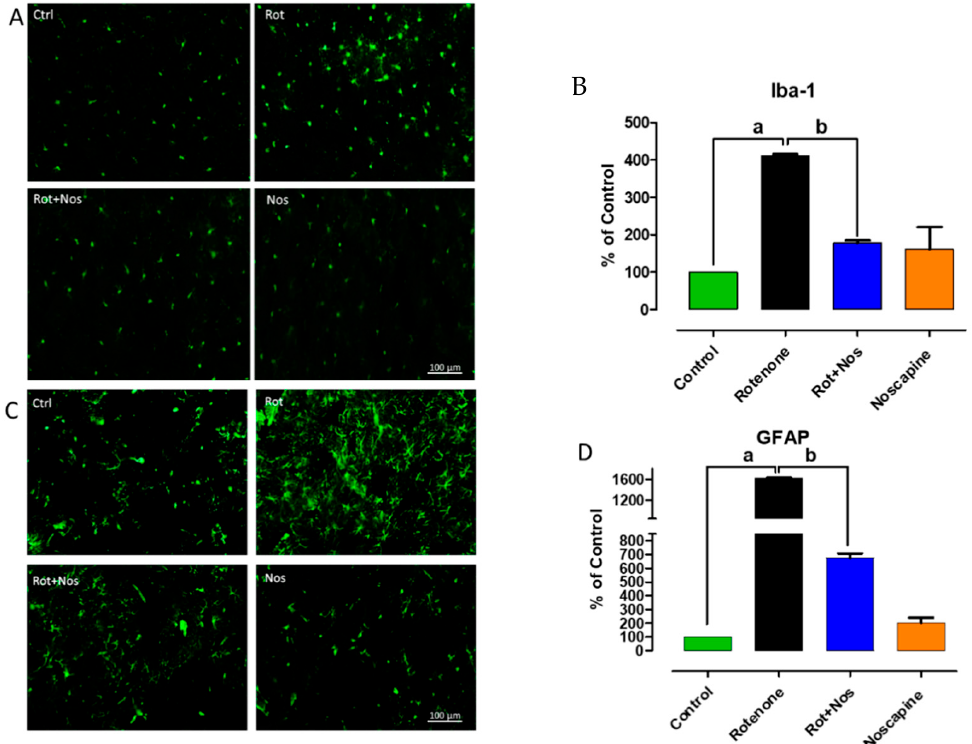
Figure 3. Noscapine prevented activation of microglia and astroglia. Enhanced expression of ionized calcium-binding adapter molecule 1 (Iba-1) and glial fibrillary acidic protein (GFAP) is an indicator of reactive microgliosis and reactive astrocytes, respectively. Our results ( n = 5) showed that activation of microglia by rotenone is evident from larger cell bodies and fewer processes ( A ). Similarly, activation of astrocytes is evident from enhanced expression of GFAP positive cells ( C ). Conversely, administration of noscapine to rotenone-treated rats significantly decreased the expression of Iba-1 and GFAP in the striatum of experimental animals. These results were concordant with the decrease in production of pro-inflammatory factors in experimental animals. Quantification of activated microglia and astrocytes is represented as percentage of control and depicted as histogram in ( B , D ) respectively. Data are expressed as mean ± SEM. a p < 0.05 compared to control, b p < 0.05 compared to rotenone-treated group.